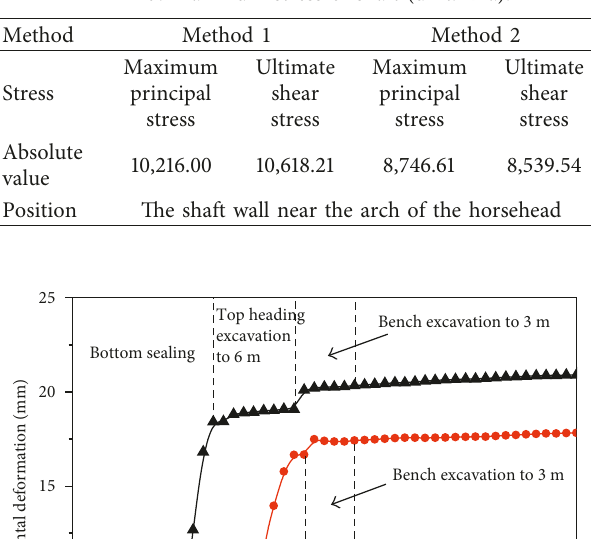
Table 5: Maximum stress of shaft (unit: kPa).